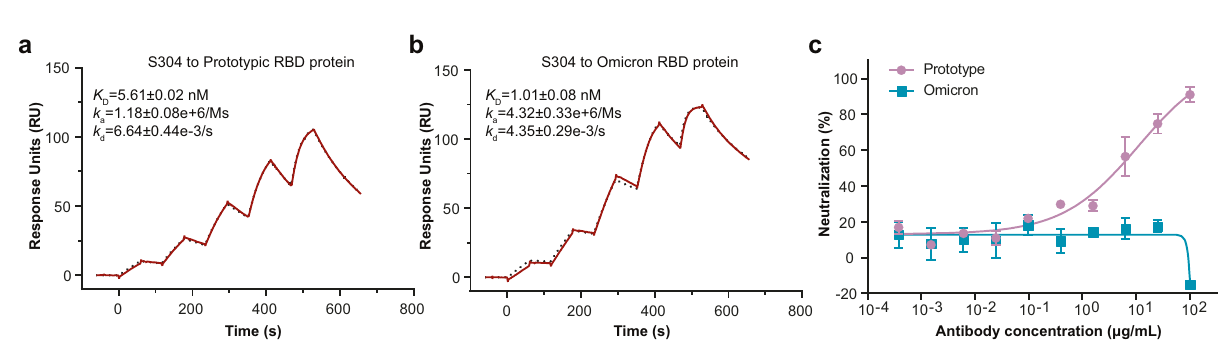
Fig. 4 | Binding af fi nity and neutralizing capacity of S304 for the Omicron variant. a , b The S304 antibody was captured on a Protein A chip and then tested forbindingwithgradientconcentrationsoftheprototypicRBD(3.125nM,6.25nM, 12.5nM, 25nM and 50nM) ( a ) and Omicron RBD (1.5625nM, 3.125nM, 6.25nM, 12.5nM,and25nM)( b )inasingle-cyclemode.Thebindingpro fi lesareshownwith time(s)onthe x -axisandresponseunits(RU)onthe y -axis.Theblackdottedcurves were obtained by fi tting data to the 1:1 binding model (Biacore Insight Evaluation software v.3.0). K D , k a , and k d values shown arethe mean ± standard deviation (SD)